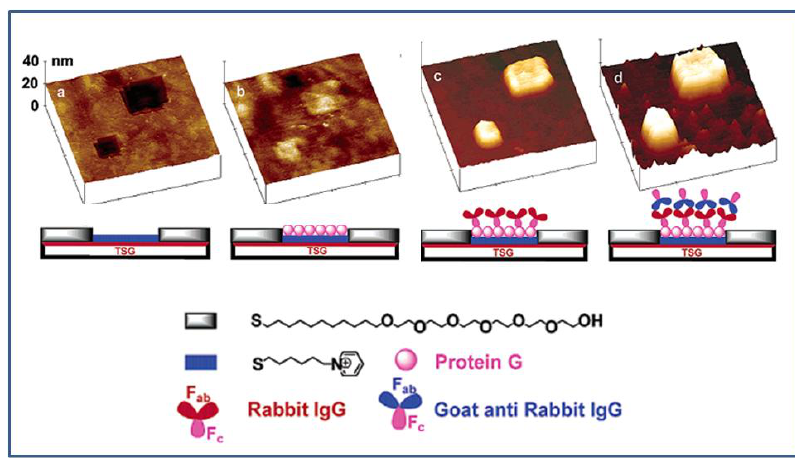
Figure 9 . 3D AFM topographic images showing the process of creating and growing the 3D protein nanostructures by electrostatic immobilization and biospecific interaction. (a) Two nanopatches (200 x 200 and 400 x 400 nm 2 ) created by nanografting of MHP into the SAM of EG OH had a depth of 2 nm. (b)After incubation with protein G, the patches were 6 completely filled by protein G with an average height of ca. 1 nm. (c) After treatment with rabbit IgG, the height of the protein nanofeatures increased to 8-9 nm. (d) After subsequent treatment with goat anti-rabbit IgG, the height of the protein nanofeatures increased to 19- 20 nm. Reproduced with permission of ACS